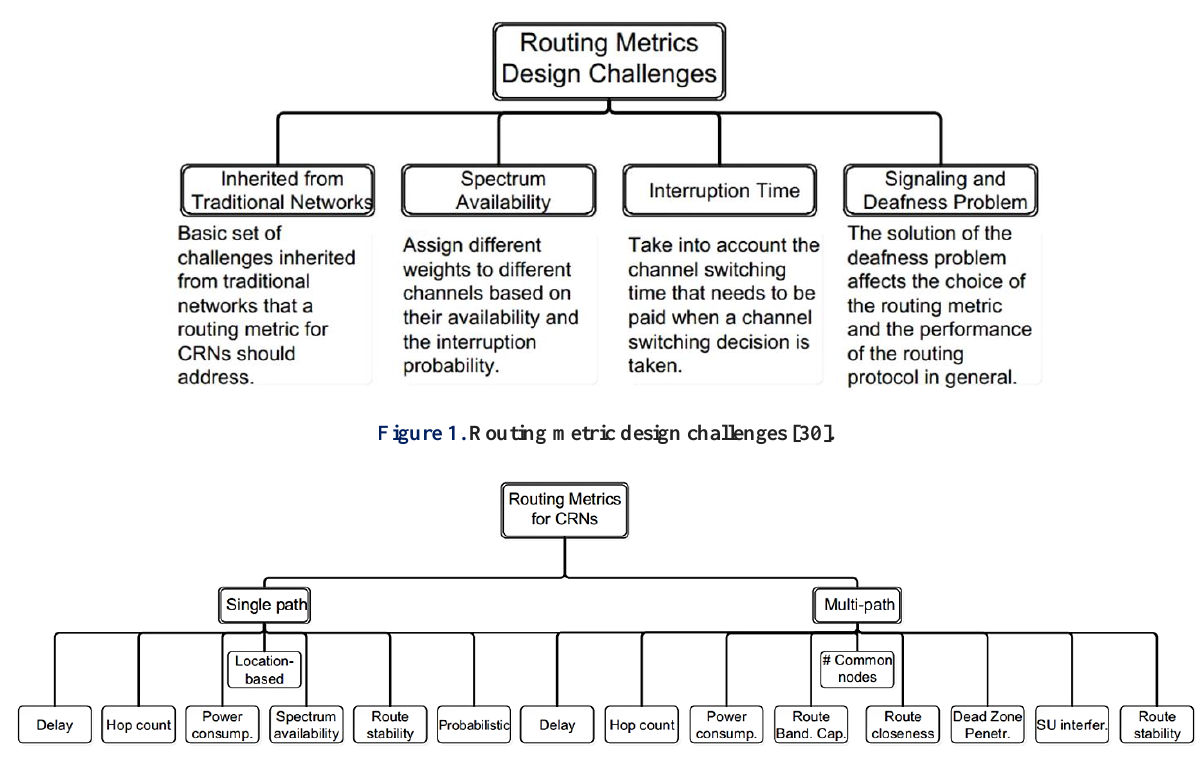
Figure 2. A taxonomy of routing metrics for CRNs